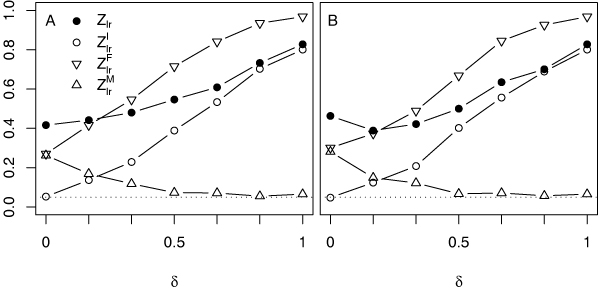
Power for the models of Table 3. (A) additive, (B) recessive. Power has been calculated for the test of linkage with full sibs Zlr (solid circles),  (circles),  (triangles point-down),  (triangles point-up). The horizontal dotted line indicates the level of the test (5%). The parameter δ has been scaled to the [0,1] interval, with a value of 1 indicating complete parent-of-origin effects. Power is estimated from 10000 replicates of 250 nuclear families.